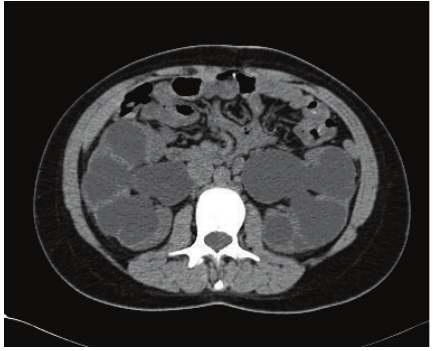
Figure 2: Preoperative CT